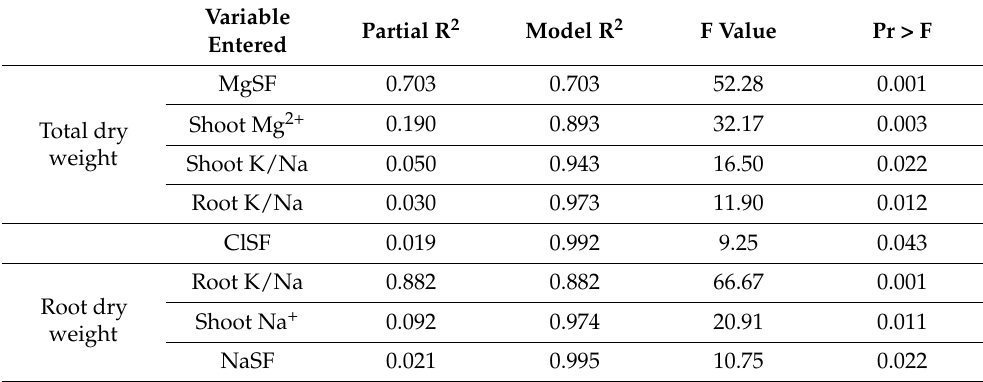
Table 5. Stepwise regression analysis between dry weight and ions accumulation and